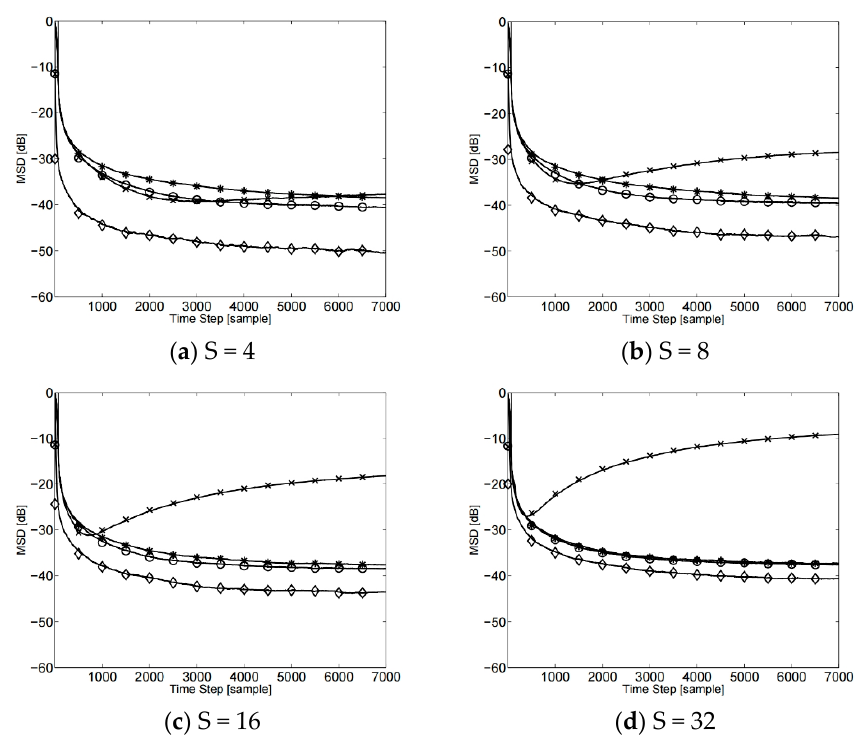
Figure 3. Steady-state MSD for S = 4, 8, 16, and 32 when applying the new ρ method to the regularization factor (-o-: l 1 -RLS with the true channel response, -x-: l 1 -RLS with the new ρ method, factor (-o-: l 1 -RLS with the true channel response, - × -: l 1 -RLS with the new ρ method, -*-: proposed -*-: proposed l 1 -RTLS with the new ρ method, -  -: oracle-RLS). l 1 -RTLS with the new ρ method, - (cid:5) -: